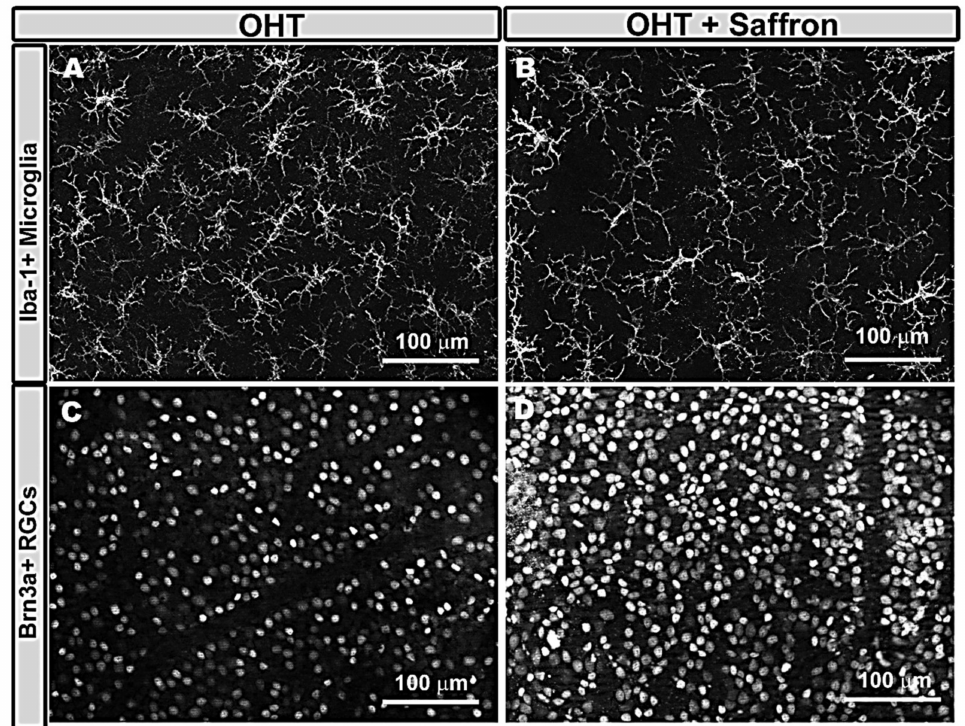
Figure 2. Immunohistochemistry of retinal whole-mount micrographs of mice eyes. The A,B retinas were labeled with anti-Iba-1 (microglia), showing the comparison of Iba-1 + microglia in the OHT untreated ( A ) and treated with saffron extract ( B ) eyes in the outer plexiform layer of the retina. It has been noted that in the OHT mice eyes treated with saffron extracts, less activation and fewer microglial cells were observed than in the untreated eyes. The C,D retinas were stained with anti Brn3a (RGCs). The C,D comparative micrographs showed the Brn3a + RGCs in the untreated ( C ) and treated with saffron extract ( D ) mice retinas. It was also detected a higher RGCs density in the treated versus the untreated rat retinas. RGC: retinal ganglion